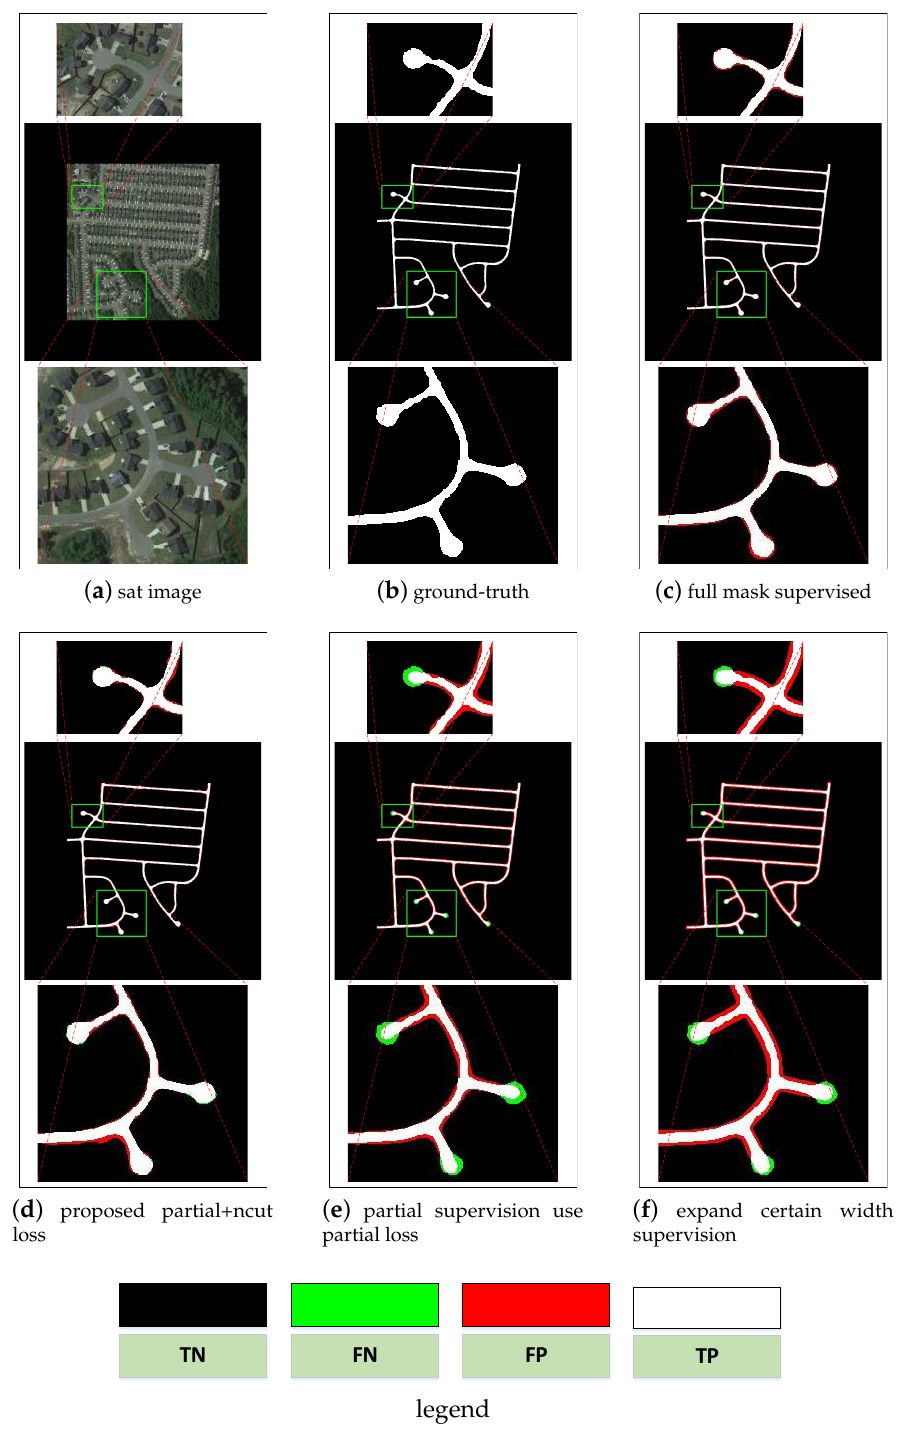
Figure 6. A sample for results with different methods on dataset 1. ( a ) The satellite; ( b ) the pixel-wise ground truth; ( c ) the extracting road using full supervised MD-ResUNet; ( d ) use of the partial loss combined with normalized cut loss; ( e ) use of the partial loss function; and ( f ) supervised by the expand